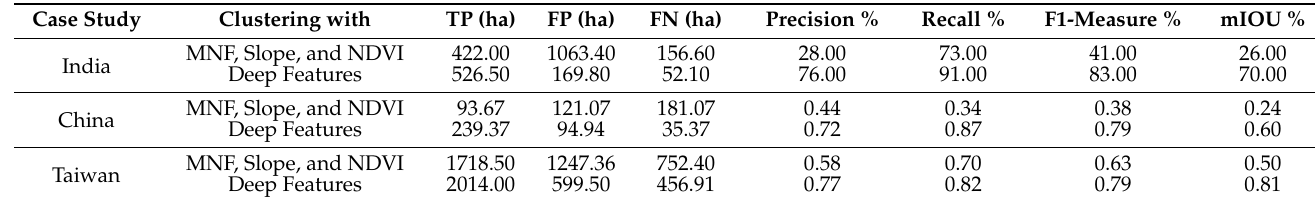
Table 4. Accuracy assessment results for both the background and landslide